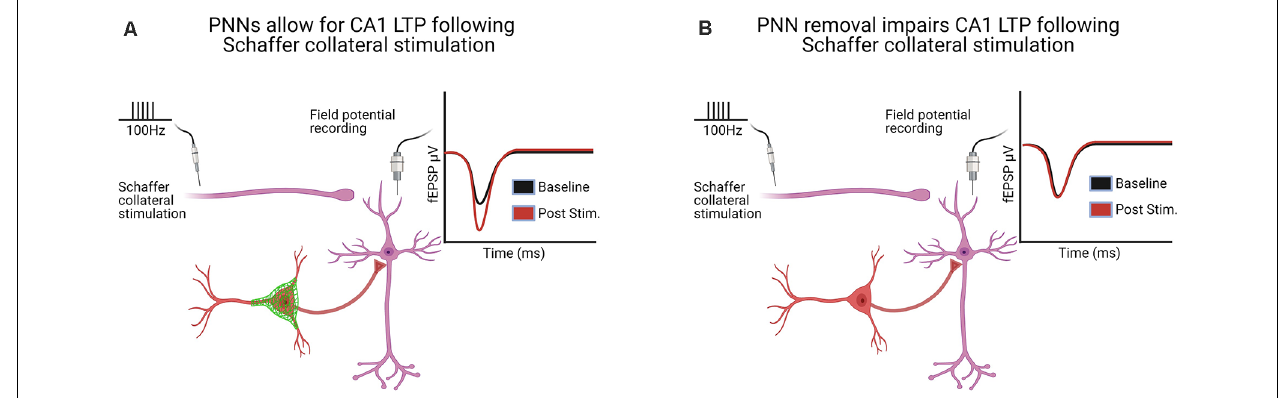
FIGURE 2 | Hippocampal long-term potentiation (LTP) in the CA1 following Schaffer collateral stimulation was altered in six of the seven studies following PNN removal [see Supplementary Table 3 for a complete list of LTP/long-term depression (LTD) and paired-pulse ratio (PPR) studies]. (A) With PNNs intact, Schaffer collateral stimulation induces LTP. (B) With PNNs removed, Schaffer collateral stimulation-induced LTP is impaired. Created with